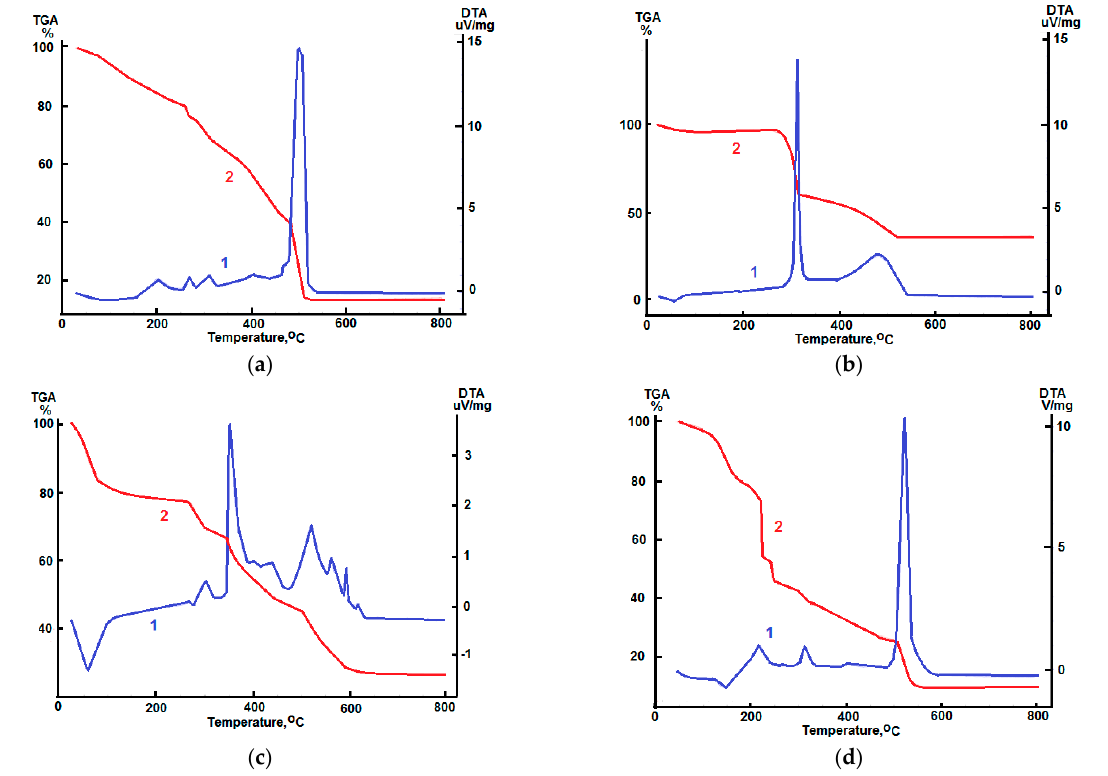
Figure 1. Thermal evolution of PVP ‐ salts composite materials. ( a ) PVP ‐ Zn(NO 3 ) 2 ; ( b ) PVP ‐ SnCl 2 ; ( c ) PVP ‐ FeCl 3 ; ( d ) PVP ‐ Zn(NO 3 ) 2 ‐ SnCl 2 ‐ FeCl 3 . 1—DTA curves; 2—TG curves.